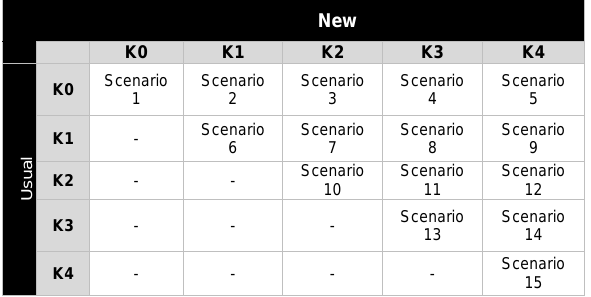
Table 1: Matrix of 15 possible scenarios comparing progressions of functional outcomes across the five Medicare Functional Classification Level (K-level) ranging from K0 to K4 without (usual) and with (new) intervention that could be considered in Step